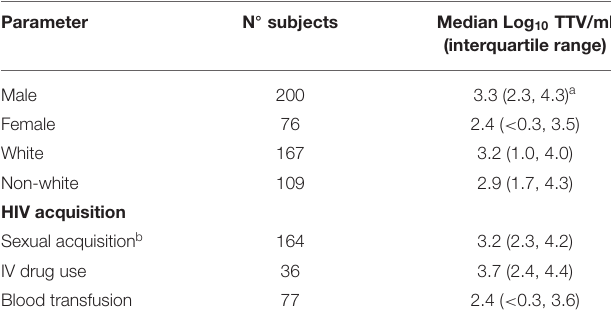
TABLE 1 | Association between characteristics of study subjects and TTV in saliva. Parameter